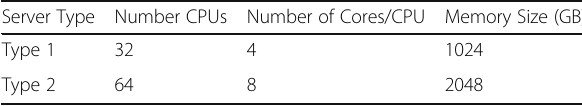
Table 3 Physical machine configuration